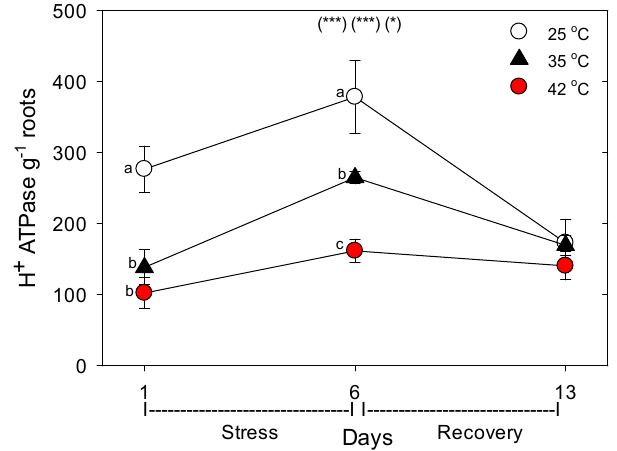
Figure 8. Effect of abrupt heat stress on relative levels of the plasmalemma H + -ATPases (per g dry root) in roots of tomato. Plants were grown at 25 °C/20 °C day/night (control), and then subsets of plants were heat stressed at 35 °C/30 °C or 42 °C/37 °C day/night for one or six days (maximum root temperatures = 32 °C or 39 °C), and then returned to control conditions for seven days of recovery (=day 13). Values are means ± 1 SE for four independent replicates from each harvest (days 1, 6, 13). Statistics are as in Figure 1. * p < 0.05, ** p < 0.01, *** p < 0.001.